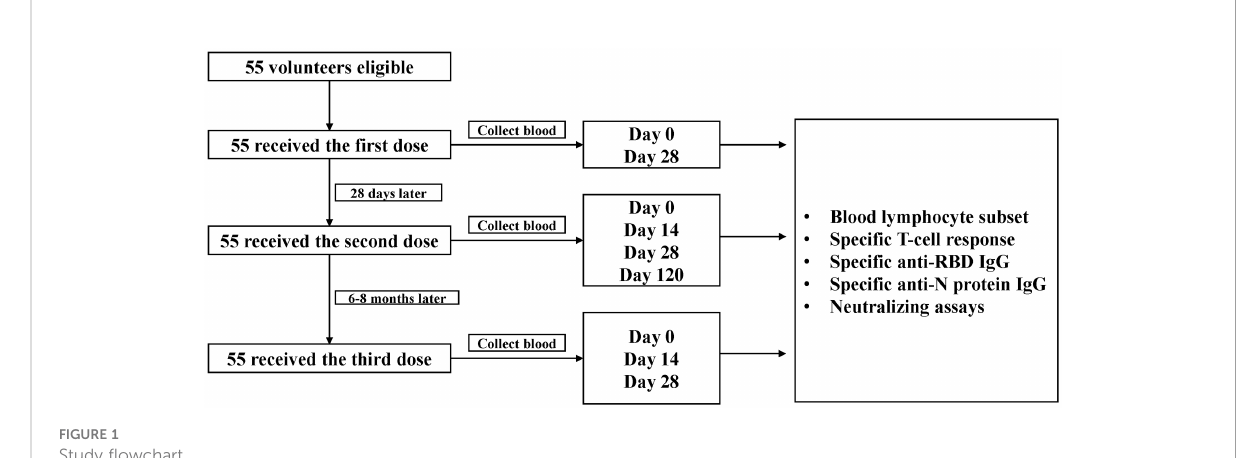
FIGURE 1 Study fl